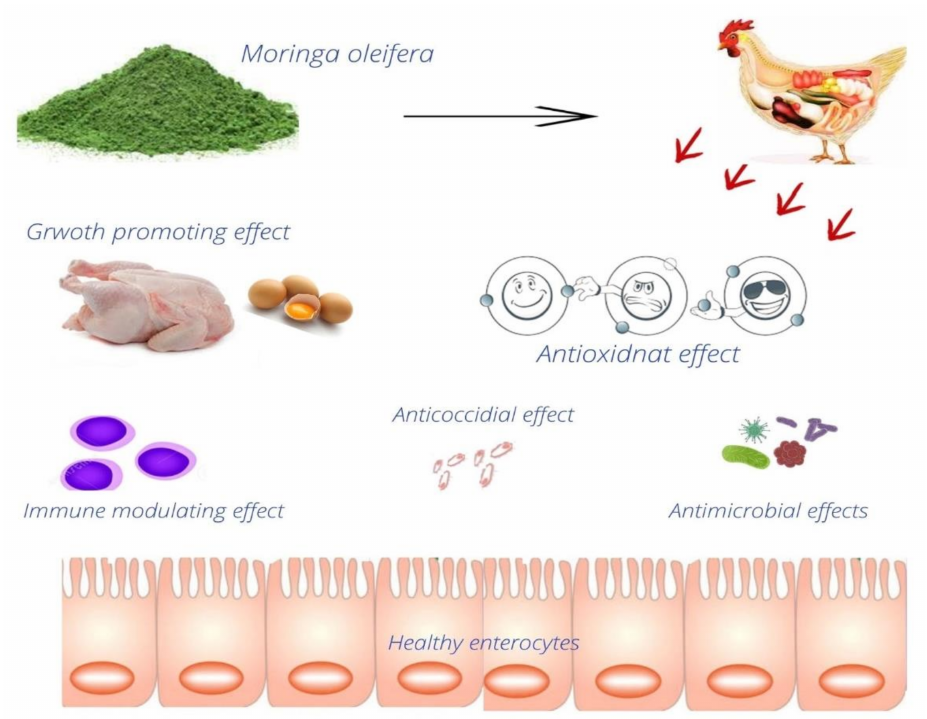
Figure 3. Example of some of the applications of M. oleifera in poultry